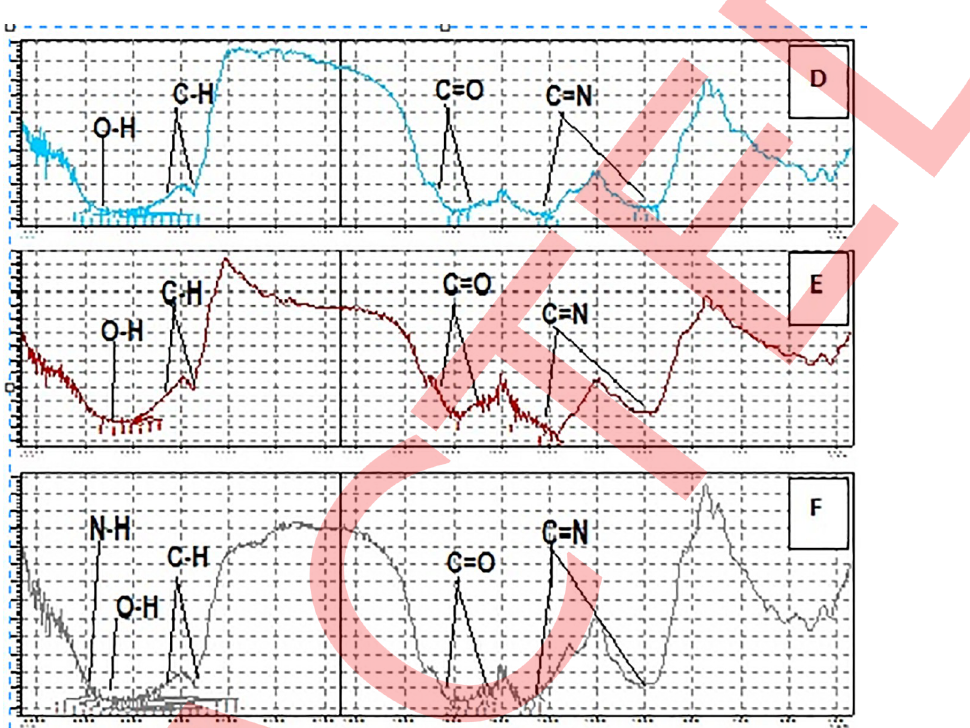
Fig 3. FTIR spectrum of fenugreek leaves of a plant grown in naturally contaminated soil without BC [D]. FTIR spectrum of fenugreek leaves of a plant grown in naturally contaminated soil with 3% BC [E]. FTIR spectrum of fenugreek leaves of a plant grown in naturally contaminated soil with 5% BC [F].